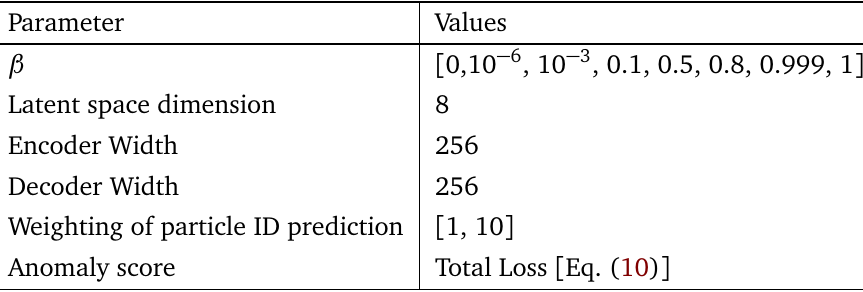
Table 8: All hyperparameters used to train DeepSet β -VAE models.